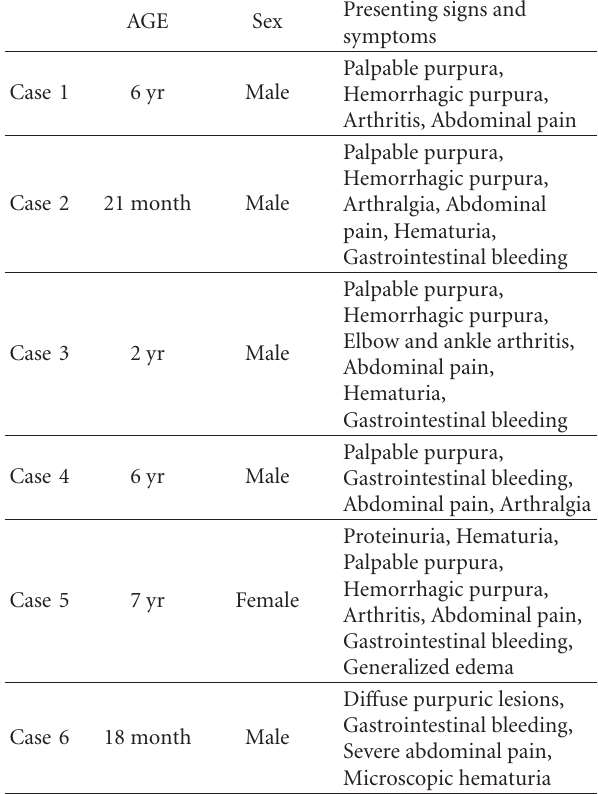
Table 1: Demographic features of